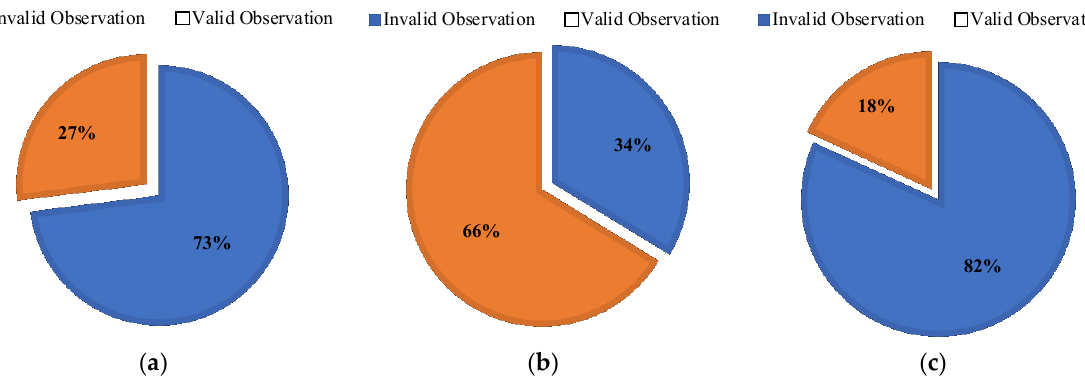
Figure 2. Percentage of valid and invalid observations for ( a ) DBST, ( b ) AC, and ( c ) CC pavement sections.